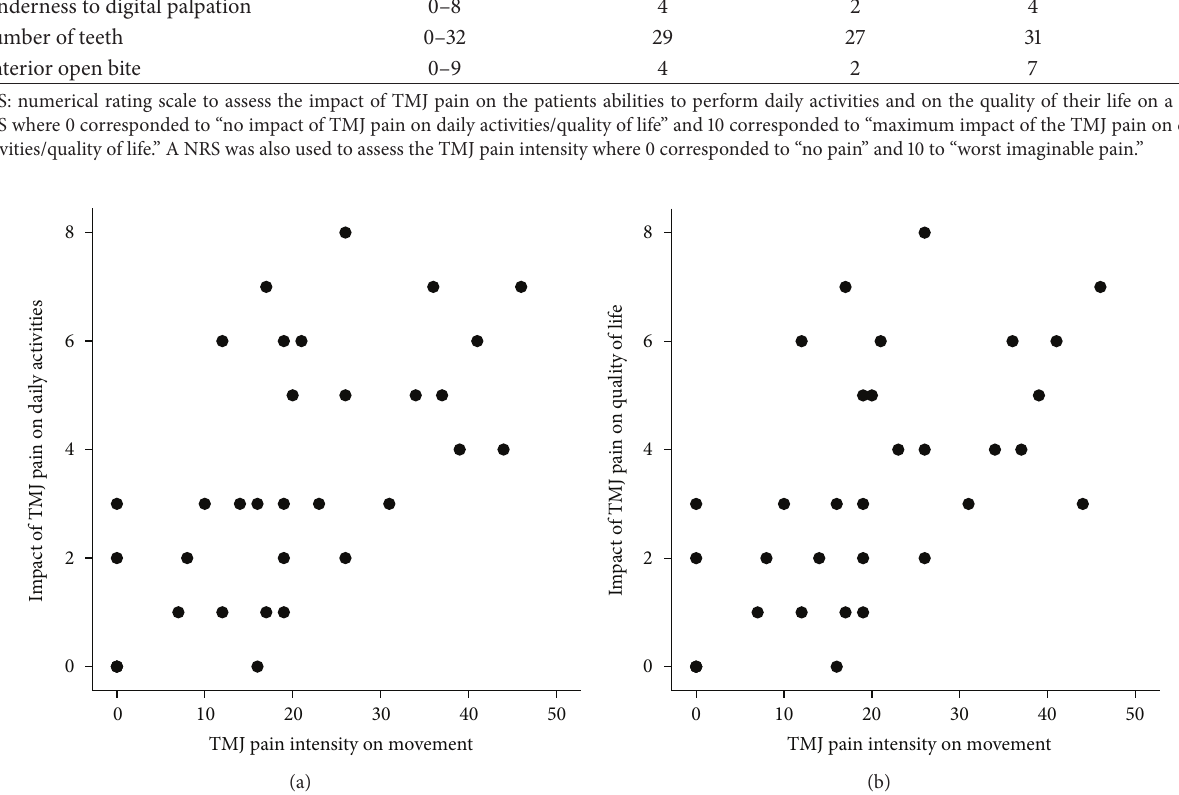
Figure 1: Scatter plots showing the relation between temporomandibular joint (TMJ) pain intensity on movement and the impact of TMJ pain on daily activities ((a): 𝑟 𝑠 = 0.72 , 𝑛 = 33 , 𝑃 < 0.001 ) and quality of life ((b): 𝑟 𝑠 = 0.73 , 𝑛 = 33 , 𝑃 < 0.001 ).